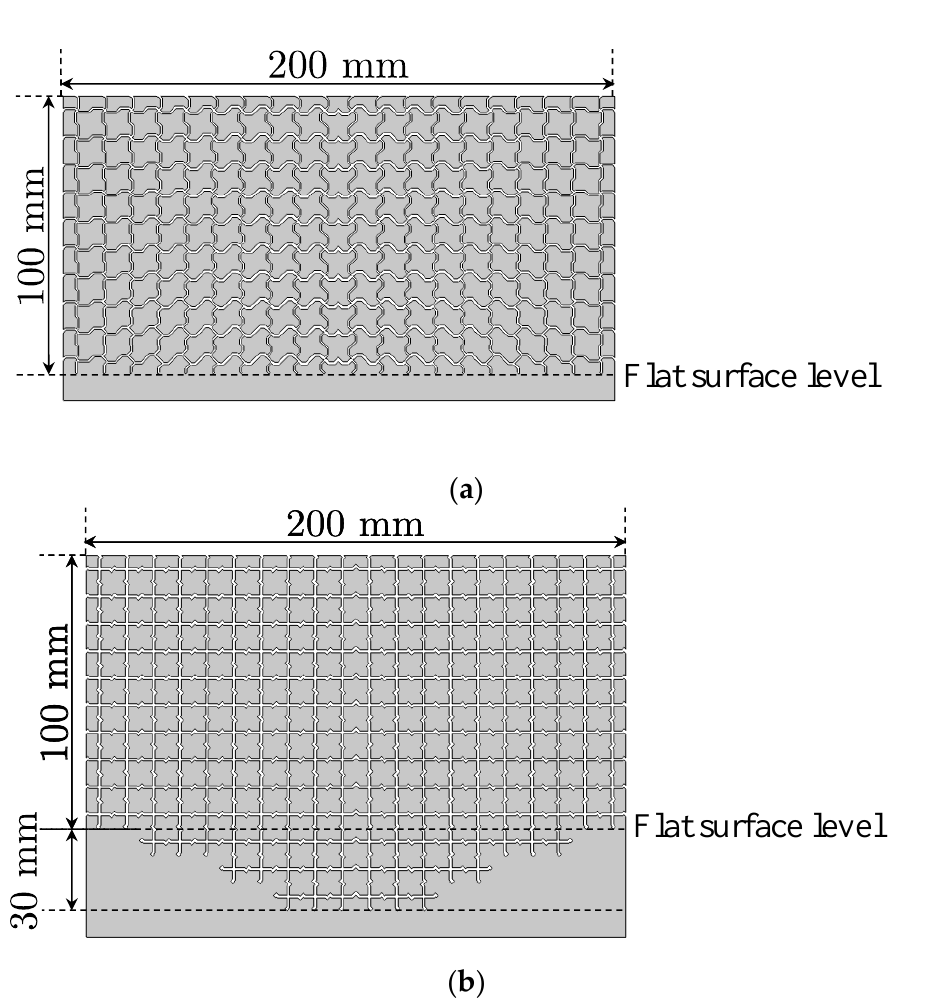
Figure 11. Designed acoustic illusion medium and the additional designed structure for comparison. ( a ) Illusion medium; ( b ) groove. These sizes are 2 p × h = 200 mm × 100 mm (2 p × h ) and those